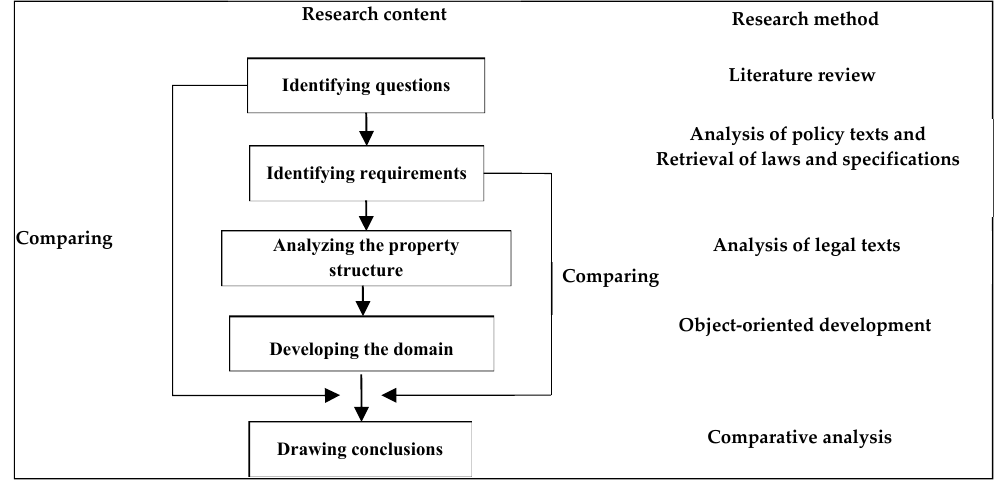
Figure 1. Research roadmap of China’s natural resource administration domain model.